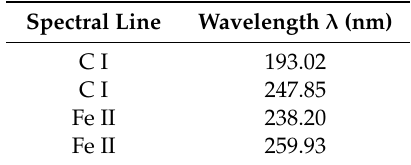
Figure 3. Optical emission spectrum of carbon ( a ), iron ( b ), magnesium ( c ), aluminium ( d ), chromium ( e ), zinc ( f ), sodium ( g ) and calcium ( h ) measured by high resolution LIBS from selected diesel particulate matter collected from in-use passenger diesel-engine vehicles. Table 1. Spectral atomic and ionic lines used for analytical LIBS measurements.